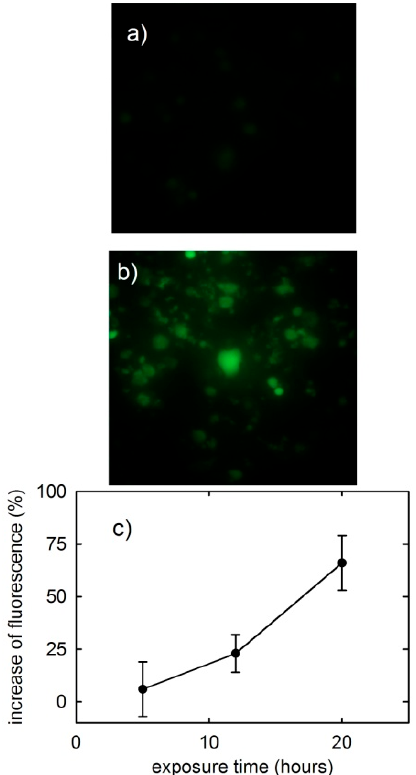
Figure 5. Typical fluorescence image of 20 h unexposed ( a ) and exposed ( b ) PBLM cells. In ( c ) the increase of percentage of dichlorofluorescein (DCF) fluorescence intensity in exposed PBLM cells with respect to unexposed ones is reported as a function of exposure time.